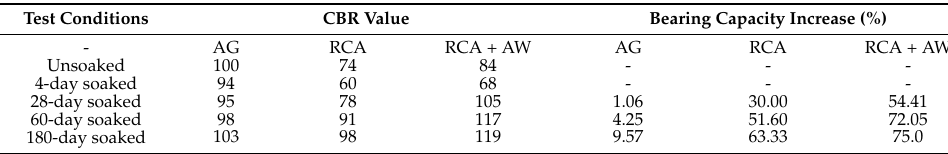
Table 5. California Bearing Ratio (CBR) value and increase.